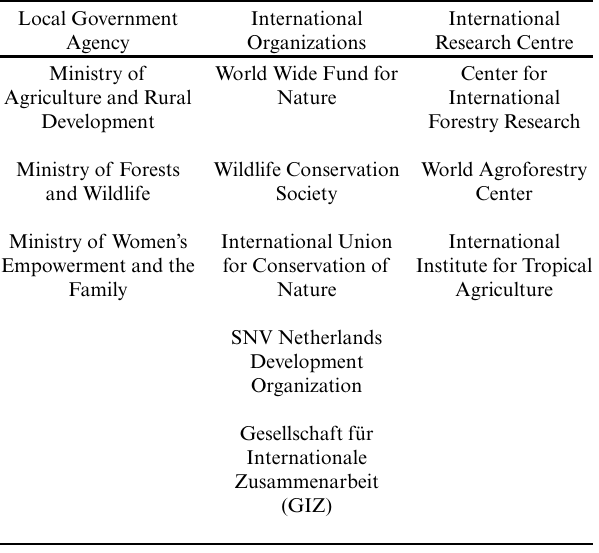
Table 4 . Summary of external institutions intervening in research